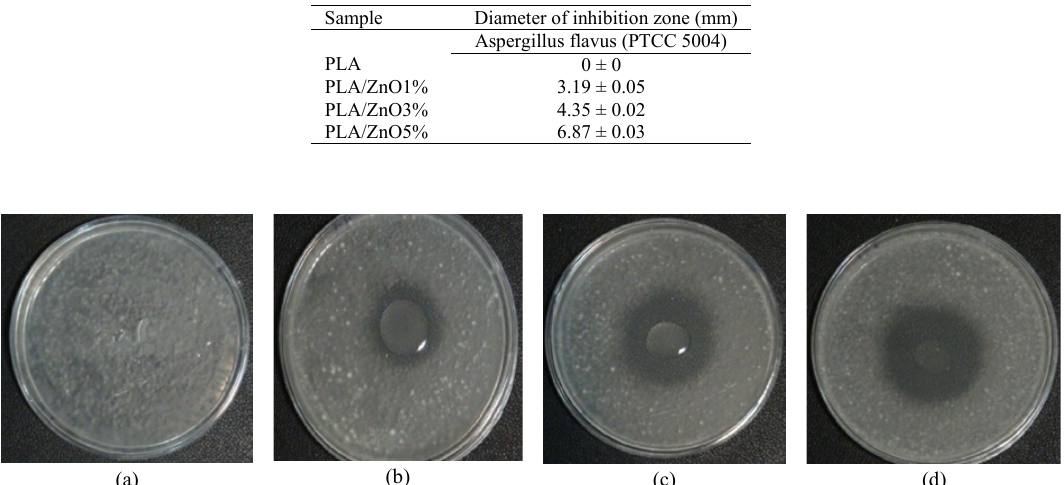
Fig. 1. Antifungal activity of nano ZnO 0, 1%, 3% and 5% (a, b, c and d) particles against Aspergillus flavus (PTCC 5004) Table 1. Diameter of inhibition zone (mm) in poly lactic acid films containing nano-zinc oxide on Aspergillus flavus (PTCC 5004)